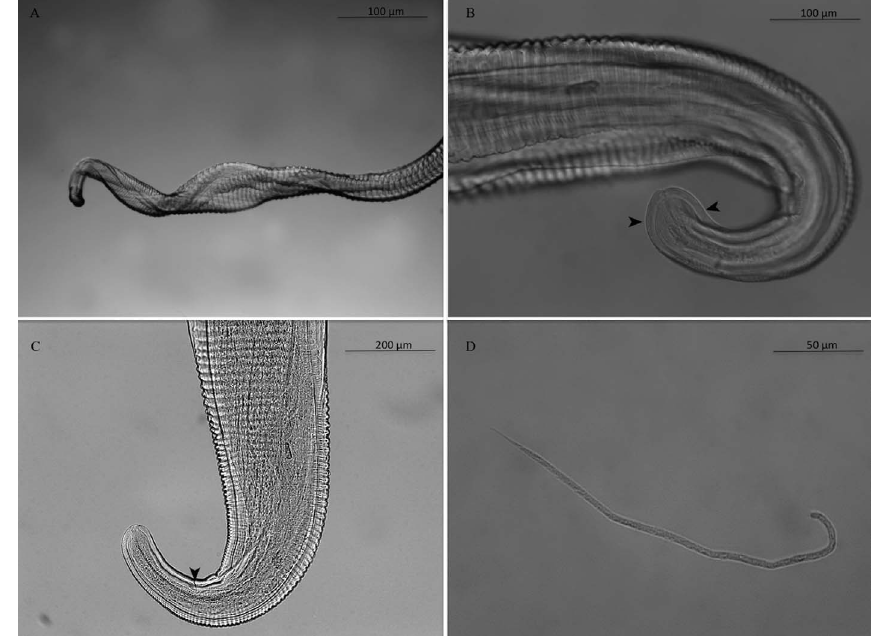
Figure 2. Adult female of Onchocerca fasciata . A. Posterior end with helicoidal twist. B. Posterior end rounded, with cuticle ridges becoming smooth (arrowhead). C. Tail, the anus (arrowhead). D. Microfilaria of O. fasciata isolated from the female uterus: anterior end rounded and tail